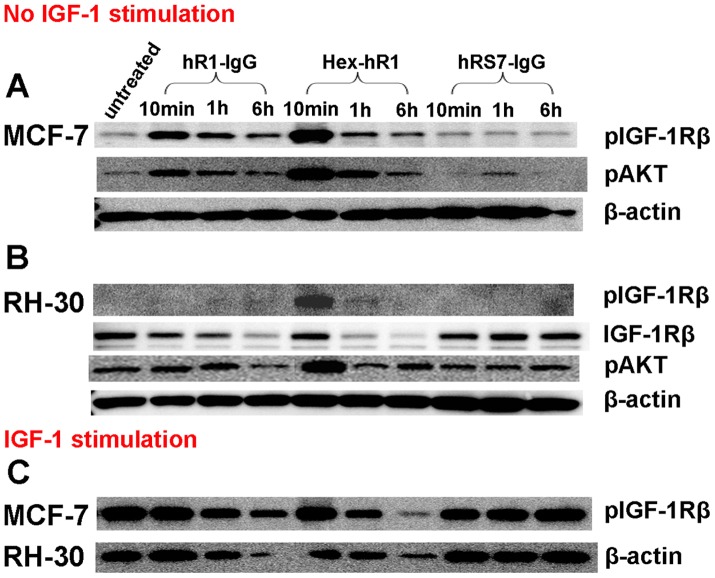
Phosphorylation of IGF-1R and Akt.(A) hR1, Hex-hR1, but not hRS7 (irrelevant IgG) induced phosphorylation of IGF-1Rβ and Akt in MCF7 cells in the absence of IGF-1; (B) under the same conditions as in (A), only Hex-hR1 was effective in inducing phosphorylation of IGF-1R1Rβ and Akt in RH-30 cells; (C) MCF7 and RH-30 cells were treated as in (A) except with the addition of IGF-1.